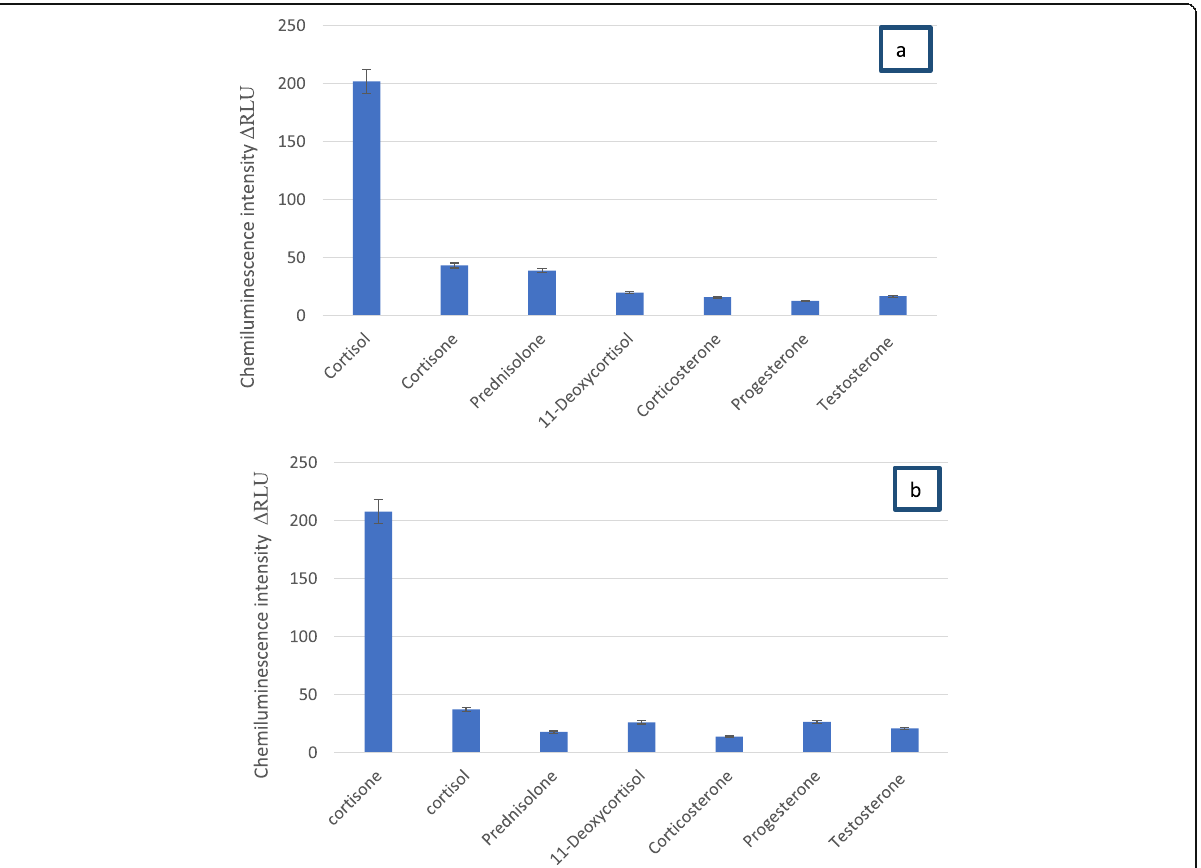
Fig. 12 Column chart specifies the similar structure compounds potential interference with a ferrocene tagged anti-cortisol antibody and b ferrocene tagged anti-cortisone